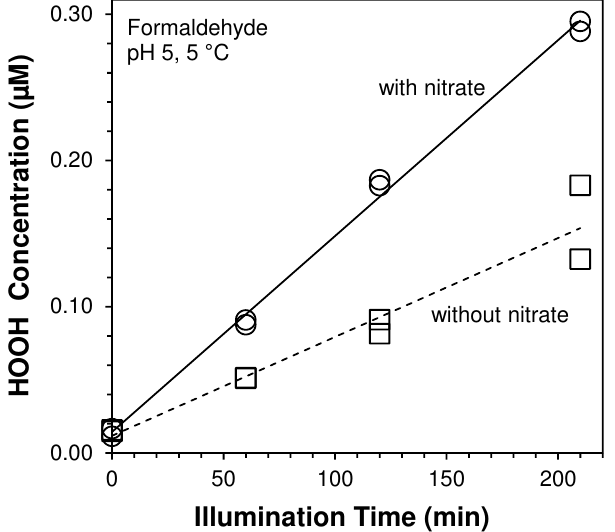
Fig. 1. Production of hydrogen peroxide in illuminated solutions (pH 5, 5 ◦ C) containing 200µM formaldehyde and either no nitrate (squares) or 500µM nitrate (circles). Rates of HOOH formation, correlation coefficients ( R 2 ) , and j (2NB) values for these two solu- tions are 0.68nMmin − 1 , 0.938, and 0.014s − 1 , and 1.3nMmin − 1 , 0.996, and 0.014s − 1 , respectively.